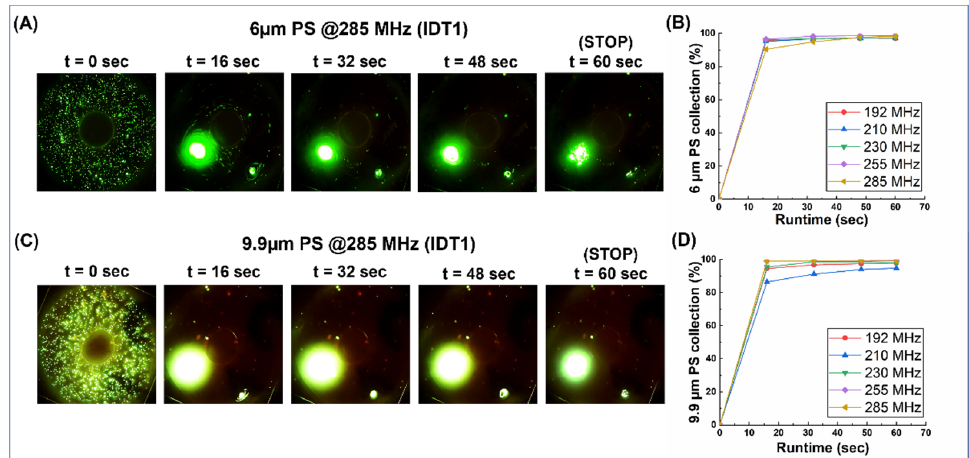
Figure 4. The frequency hop results from the collection of 6µm and 9.9 µm polystyrene beads with a load volume of 3 µL. It was noted that these particles showed a greater degree of settling at the bottom of the process chamber when compared to other sizes but, nevertheless, the collection showed a marked improvement at higher frequencies. ( A , C ) Snaps from the collection videos of 6 µm and 9.9 µm (respectively). ( B , D ) graphs plotting the collection (%) vs. time for 6 µm and 9.9 µm (respectively).